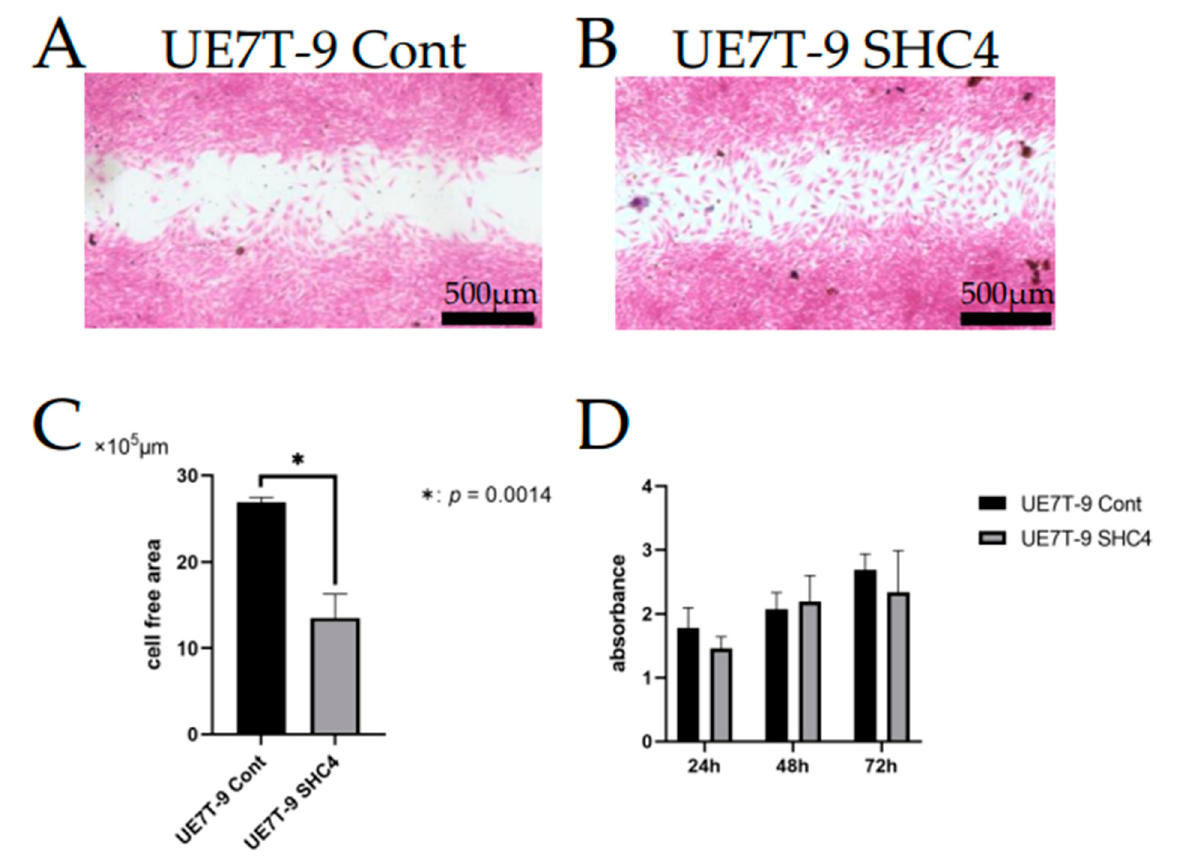
Figure 3. Evaluation of migration and proliferation. ( A , B ) Photographs of HE staining of UE7T-9 cells after 18 h of culture in scratch assay (A: UE7T-9 Cont B: UE7T-9 SHC4). ( C ) The graph shows the cell-free area of the scratched UE7T-9 cell culture after 18 h of culture, as measured by Image J. The cell-free area of UE7T-9 SHC4 was significantly decreased compared to the control ( p < 0.05), indicating enhanced migration due to SHC4 overexpression. ( D ) Evaluation of proliferative potential by MTS assay. No significant difference in proliferation was observed between the UE7T-9 control and the UE7T ‐ 9 SHC4.